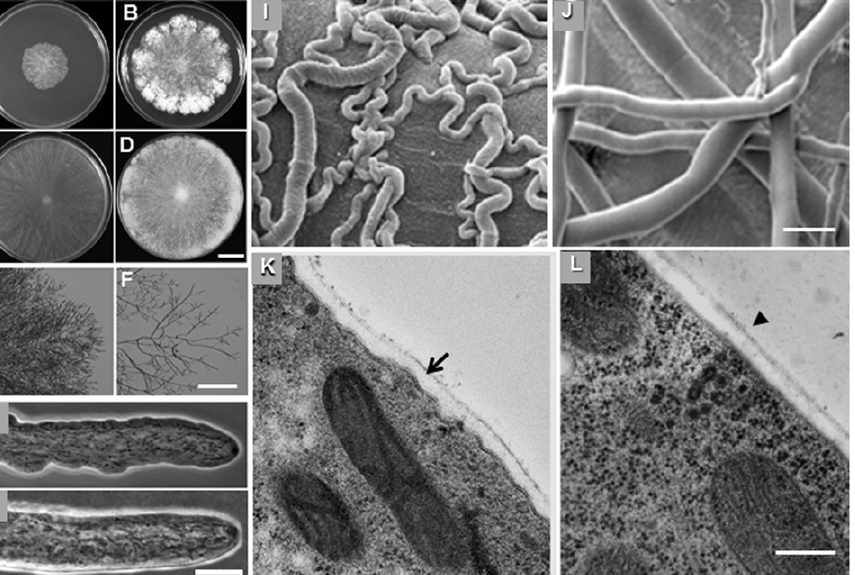
Figure 4. Phenotype of D crn-1 mutant. Colony morphology of (A–B) D crn-1 mutant and (C–D) WT strain after 24 and 48 h of incubation on VMM at 28 6 C. Low magnification images of the colony edge of (E) D crn-1 mutant and (F) WT strain. Phase contrast images of hypha of (G) D crn-1 mutant and (H) WT strain. SEM images of (I) the meandering phenotype of D crn-1 mutant hyphae and (J) the straight WT hyphae. TEM images of the subapical region of 6 h-old germlings of (K) D crn-1 mutant and (l) WT strain. A comparison of the uneven thickness of the cell wall and the ruffled plasma membrane of the mutant (arrow) with the uniform envelope of the WT (arrowhead). Scale bars=(A–D) 2.5 cm, (E–F) 100 m m, (G–J) 10 m m, (K–L) 1.0 m m.